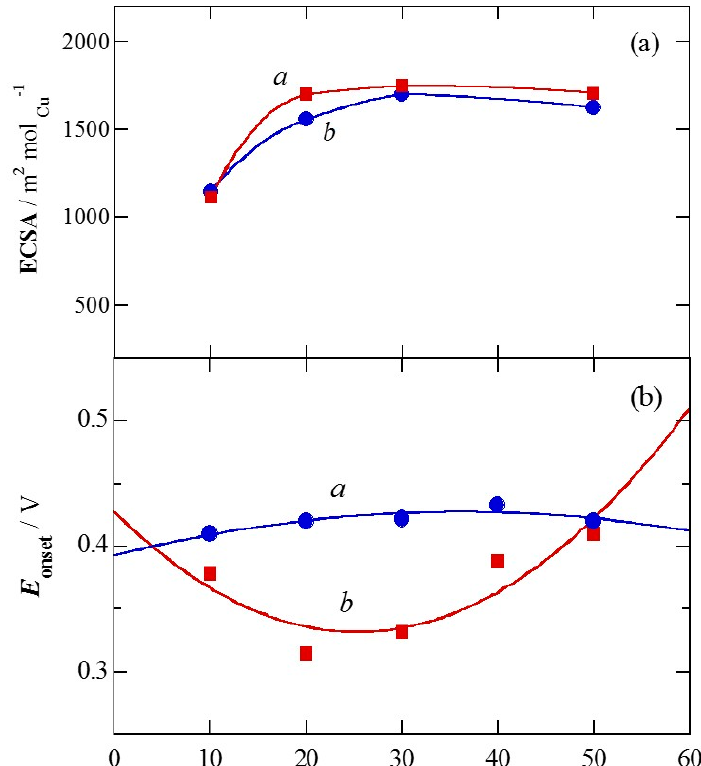
Figure 8. ( a ) Electrochemical surface areas for CO oxidation per mol of electrodeposited Cu on the Pt-Ru(Cu)/C (curve a ) and the Pt(Cu)/C (curve b ) electrocatalysts; ( b ) onset potentials for CO (curve a ) and methanol oxidation (curve b ) on the Pt-Ru(Cu)/C electrocatalyst in front of the spontaneous deposition time of Ru species from the quiescent solution.